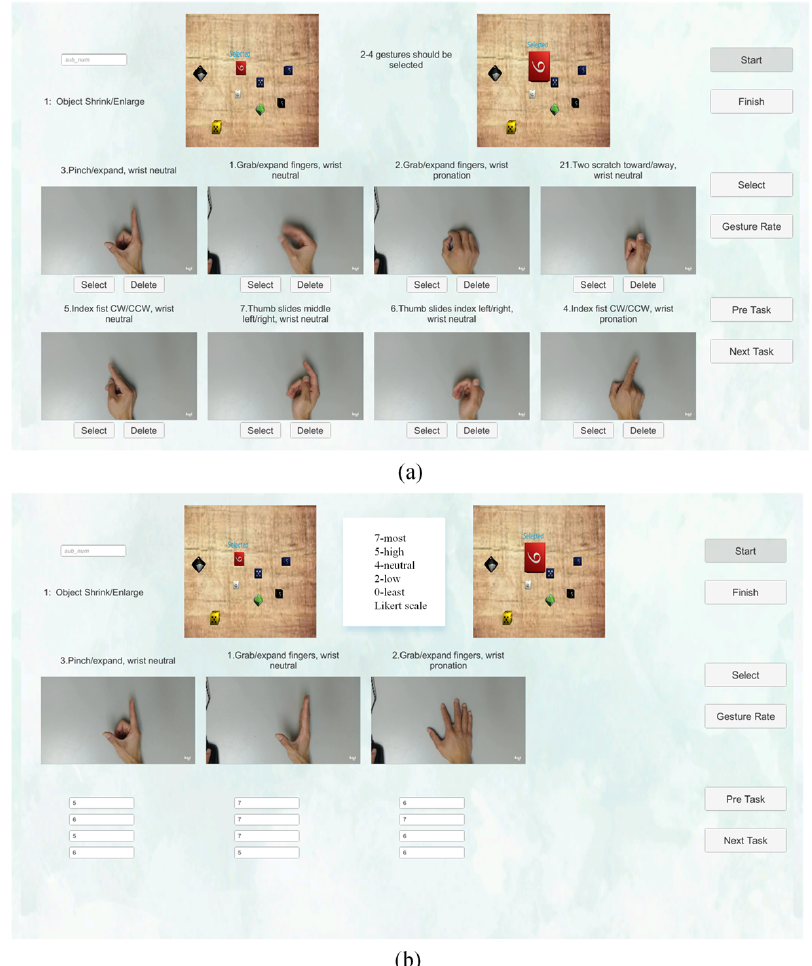
Figure 3. The selection interface for each command consisted of two screens, ( a ) the first screen showed the pre-selected eight microgestures for the command and participants selected the 2 to 4 microgestures that best matched the command; ( b ) the second screen was for rating the selected microgestures on preference, match, comfort, and